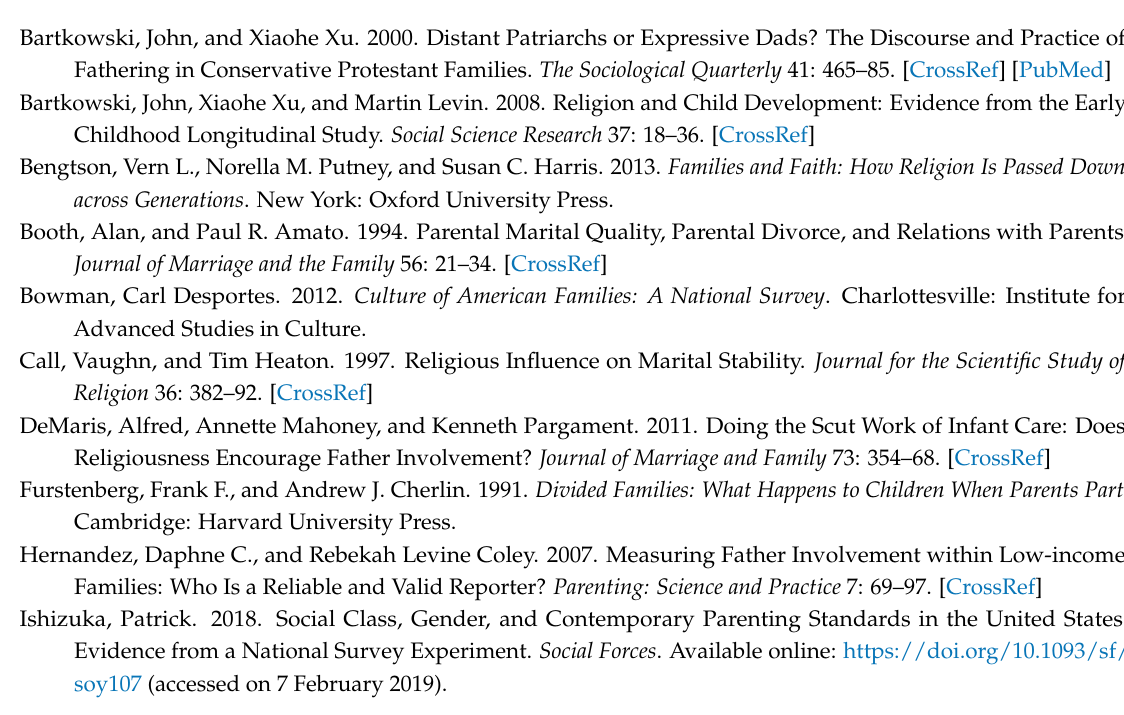
Standardized beta coefficients are presented in the table. Robust standard errors are omitted due to space constraints. The reference categories are non-Hispanic White, not all male child, not all biological child, not intact, evangelical Protestant, religiously homogamous, † p < 0.10, * p < 0.05, ** p < 0.01, *** p <